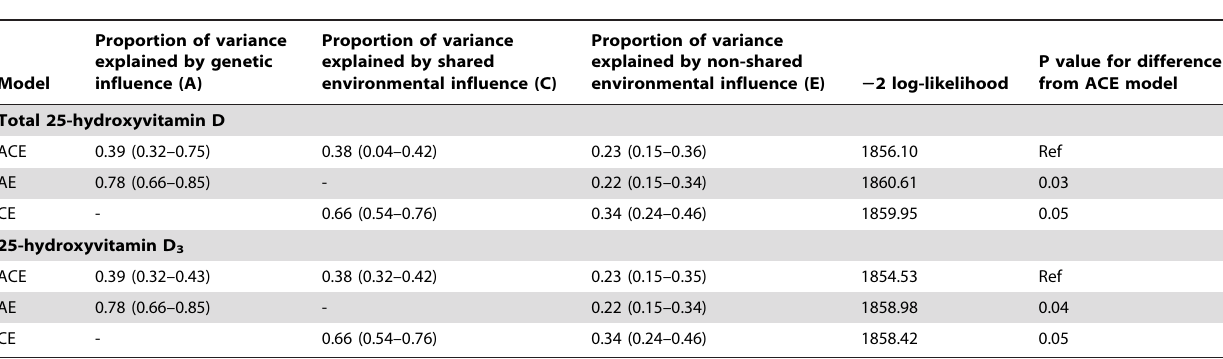
Table 2. The age-adjusted genetic, shared and non-shared (individual specific) environmental influences on variance of serum vitamin D levels (95% CI) among 204 Swedish adult